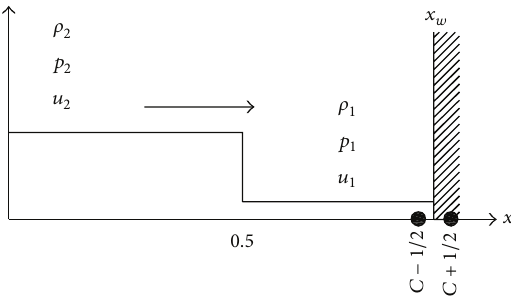
Figure 3: Schematics for analysis on Δ